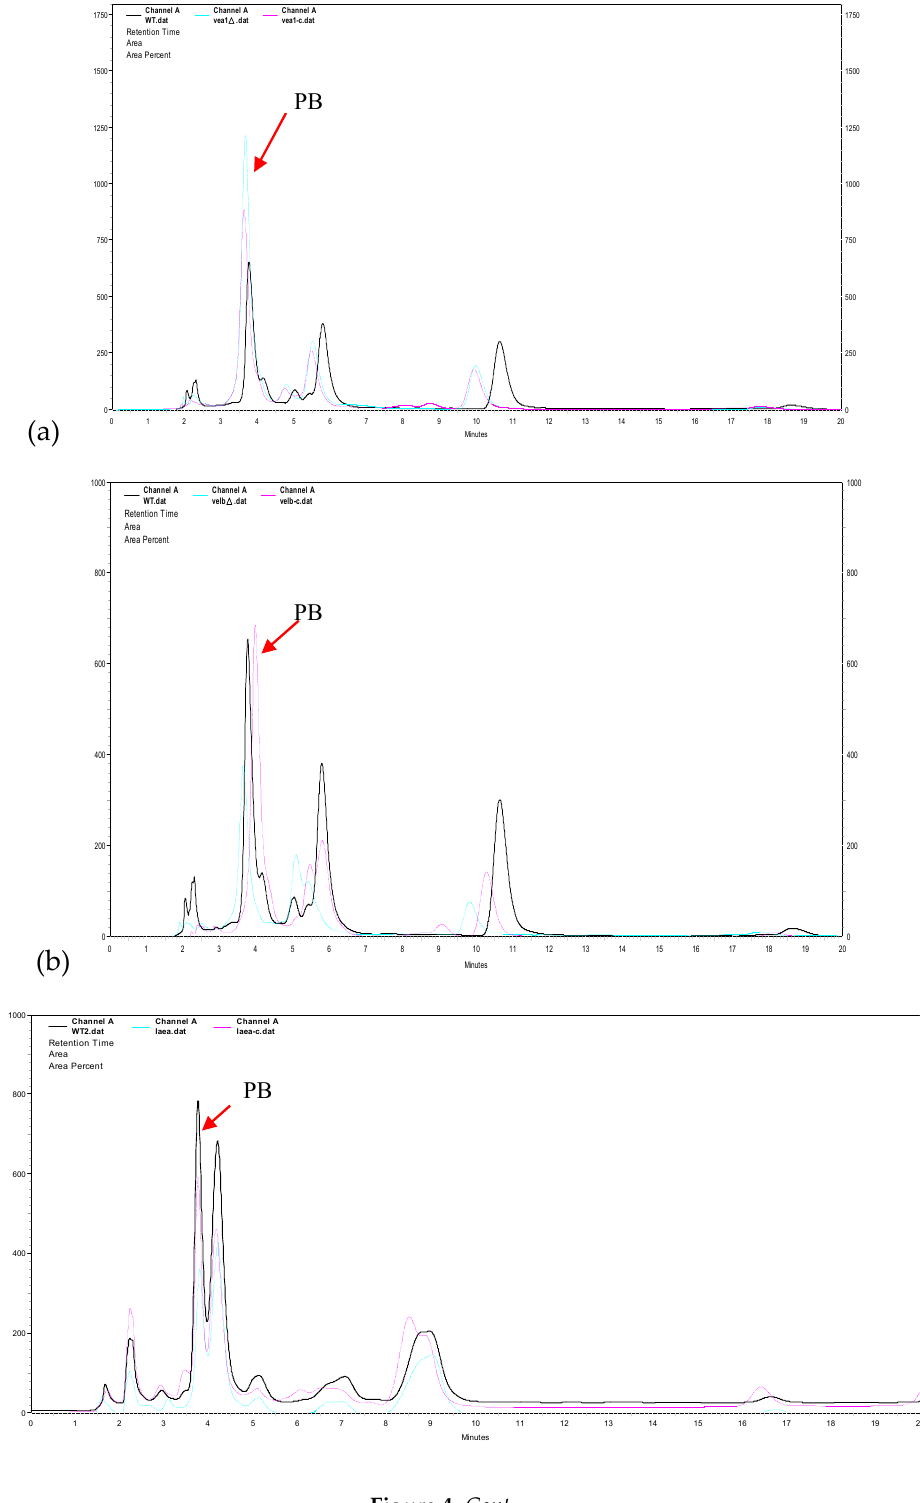
Figure 4. Cont. Figure 4.